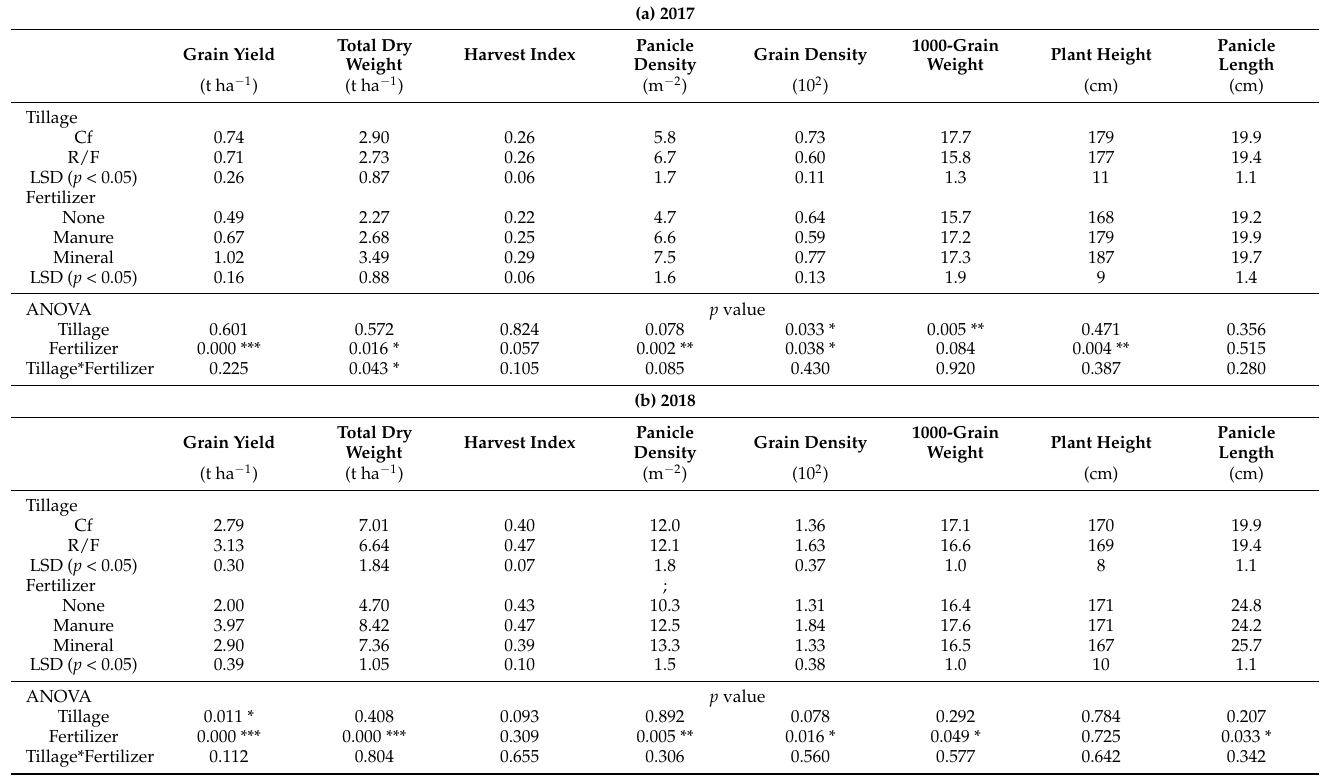
Table 2. Averages and results of ANOVA for comparison of yield and yield components of pearl millet among tillage and fertilizer treatments.